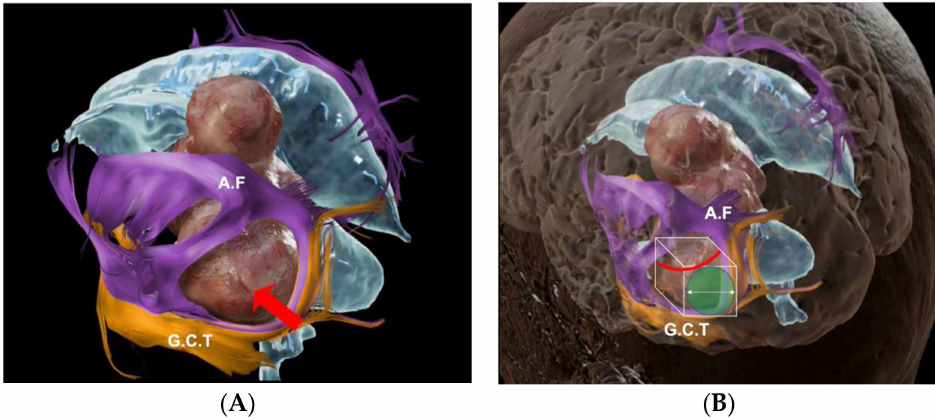
Figure 2. ( A , B ) show MRI rendering of a large intraventricular tumor (red arrow). Arcuate fasciculus (AF), geniculocalcarine tract (GTC) reconstruction helps in the planning stange for the resection of the